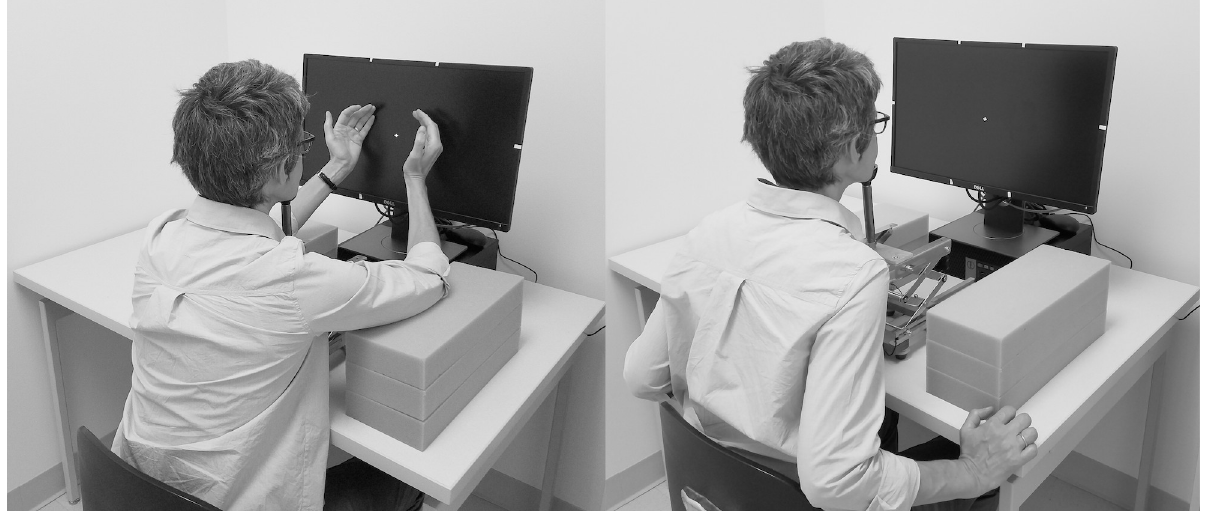
Fig 1. Experimental set-up. The setup used for the proximal (left) and distal (right) position used in the experiment.